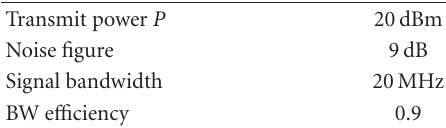
Table 1: Noise level